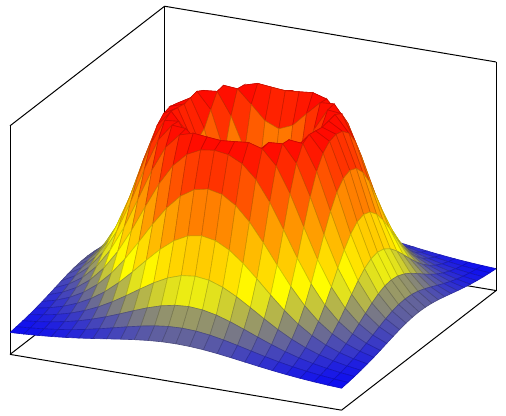
Figure 3 . A pair of coincident Jackiw-Pi vortices in a rotationally symmetric